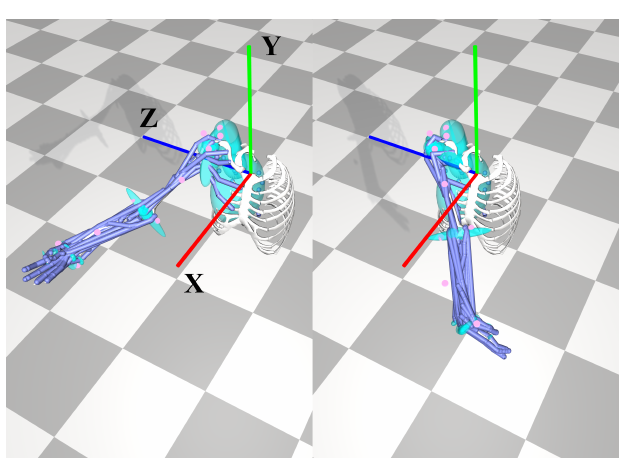
Figure 3. Pick-and-place trajectory in OpenSIM.